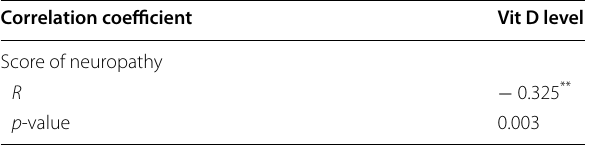
Table 5 Correlation between vitamin D level and score of